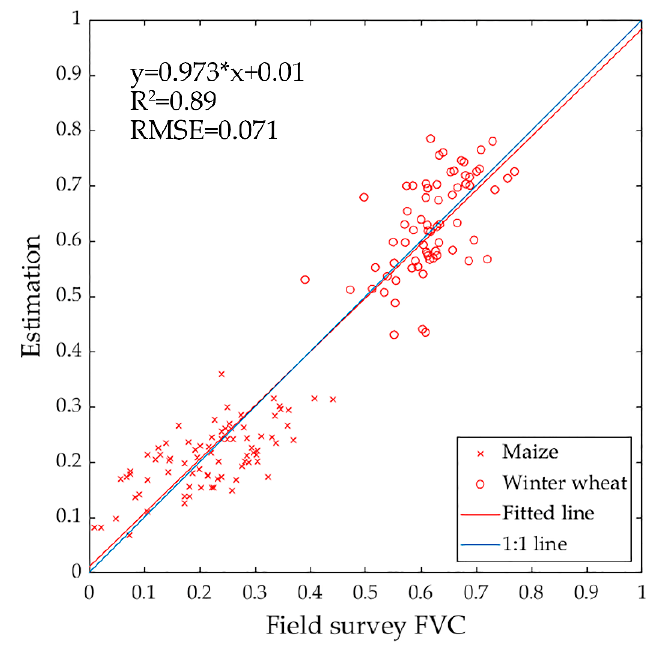
Figure 6. Validation based on field survey FVC.